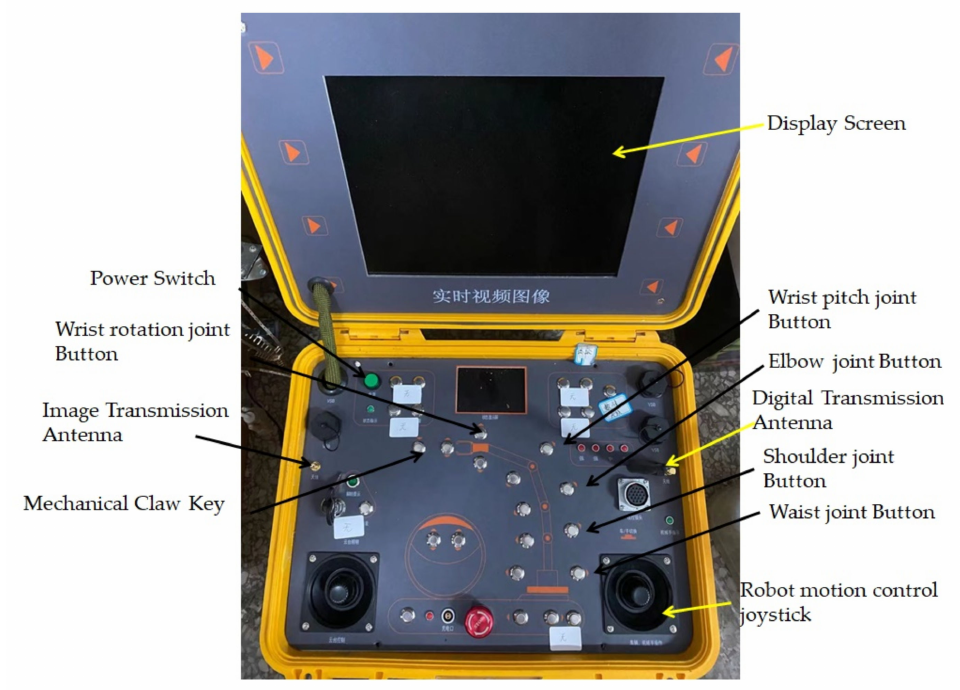
Figure 10. The remote control box MCU.